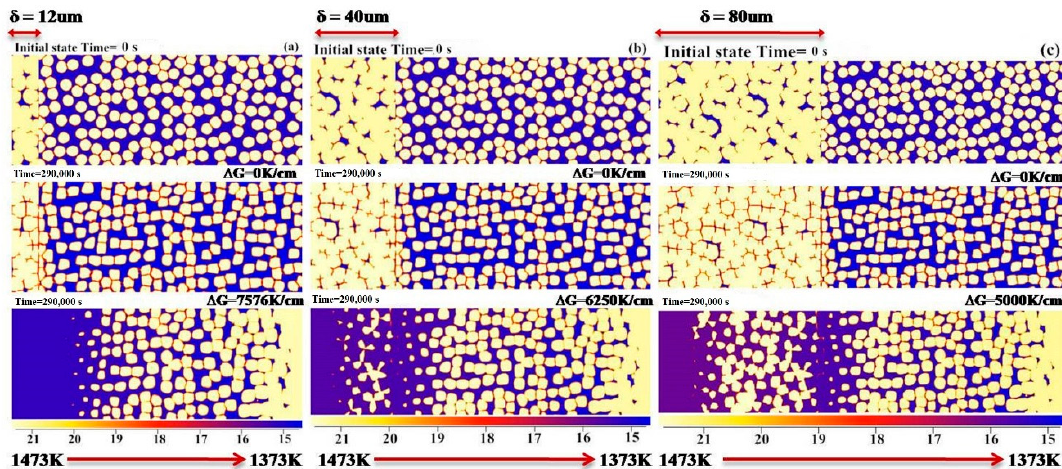
Figure 13. Interdiffusion microstructure evolution of No. 3 bond coat/substrate system (Ni–20at.%Al–4at.%Cr/Ni–18at.%Al–12at.%Cr) with different bond coat thickness at constant temperature 1373 K and with an effect of temperature gradient ( Δ G = 5000 K/cm):( a ) 12 μ m, ( b ) 40 μ m, and ( c ) 80 μ m. The color bar scale indicates the mole fraction of Al in atom percent.